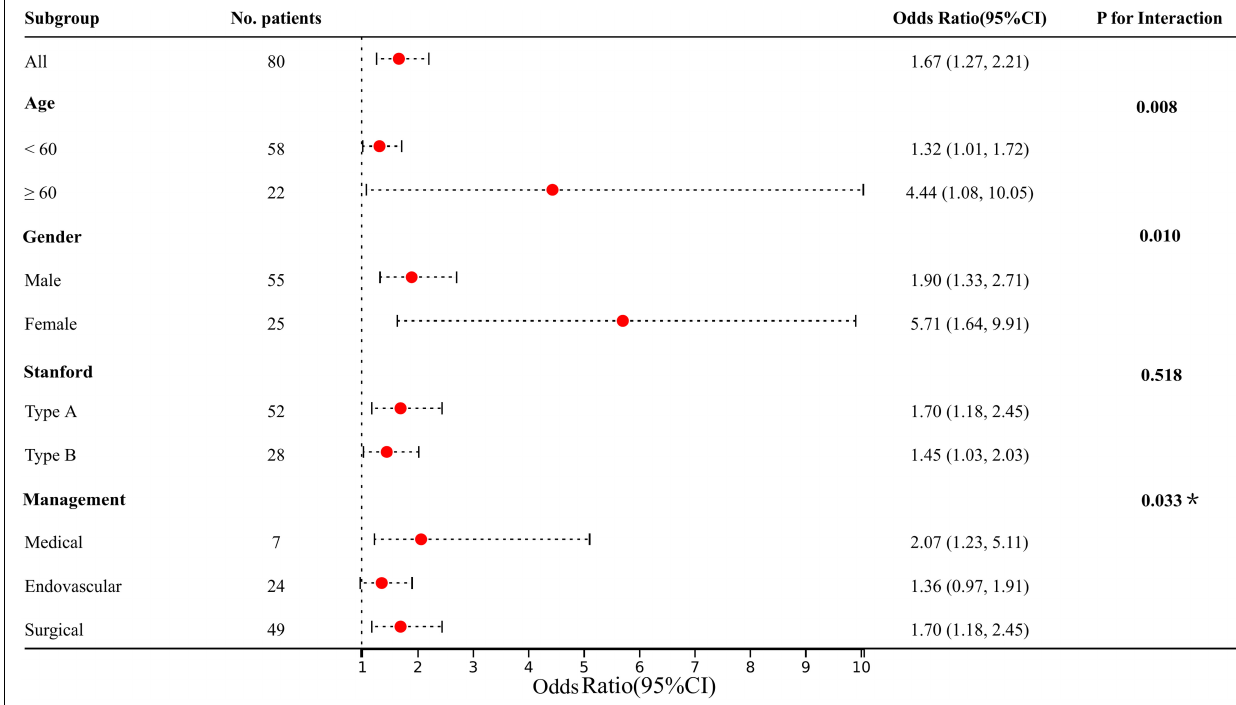
FIGURE 3 | Results of subgroup analysis and interaction analysis between LPA and AKI (LPA per 10 increments). All adjusted for age, gender, hypertension, diabetes, Marfan syndrome, COPD, medication history of aspirin, Stanford type, WBC, and management. * P -value for the management is for the comparison of patients treated medically with patients treated